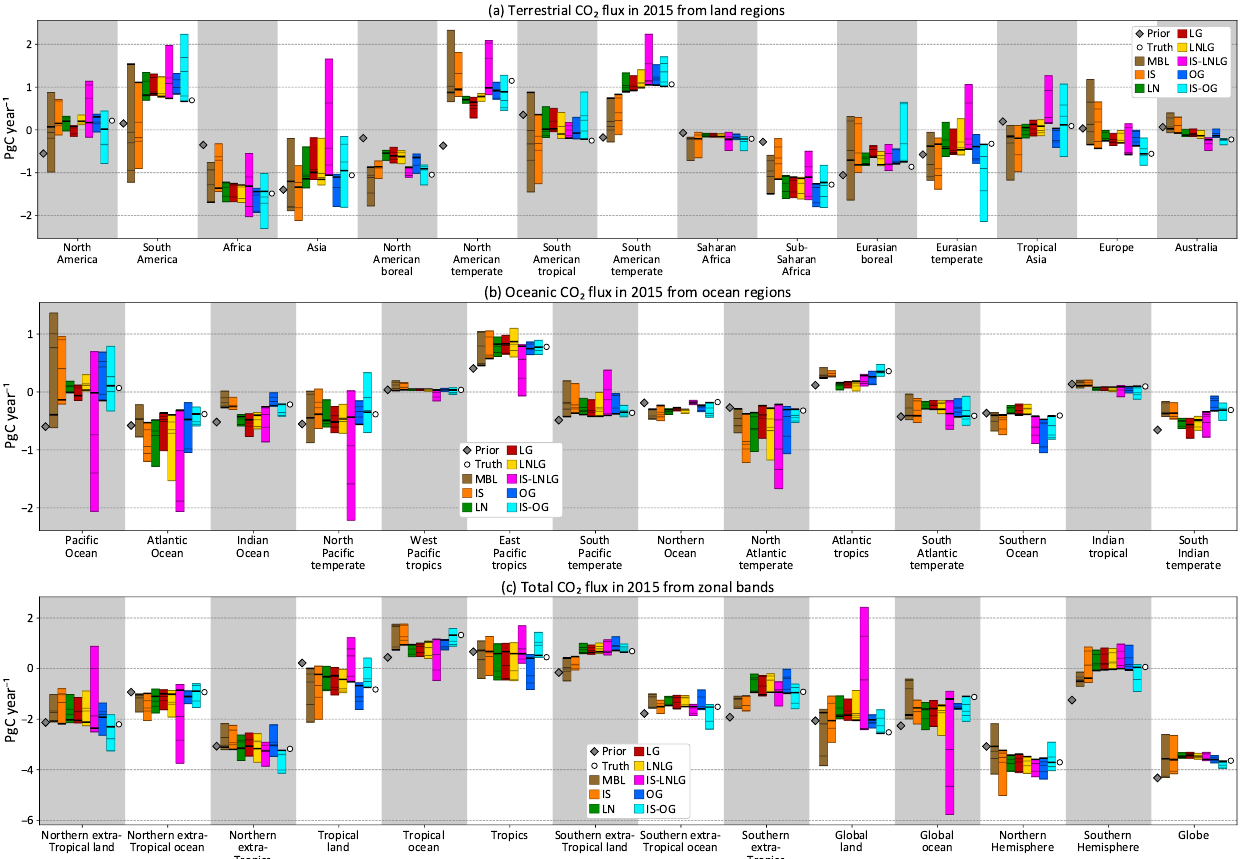
Figure 4. Annual flux estimates from land (a) and ocean (b) regions and zonal bands (c) . For each region, the prior and true fluxes are shown by a gray diamond and a white circle, respectively. The different color bars correspond to different synthetic data streams assimilated: IS stands for in situ; LN, LG and OG stand for OCO-2 land nadir, land glint and ocean glint, respectively; and LNLG = LN + LG (all land soundings). The data streams IS-LNLG and IS-OG are theoretical PBL sampling networks at OCO 2 sounding locations and times, described in Sect. 2.3.3. For each color, the vertical extent of the bar denotes the range (minimum to maximum) of the flux estimates from pseudo- data produced by the five transport models for that data stream. The black horizontal line through each bar denotes the estimate from TM5 pseudo-obs, while the fainter horizontal lines denote the estimates from the pseudo-obs produced by the other four models. The individual models are not distinguished here for visual clarity but are marked separately in Fig. D1 in Appendix D.